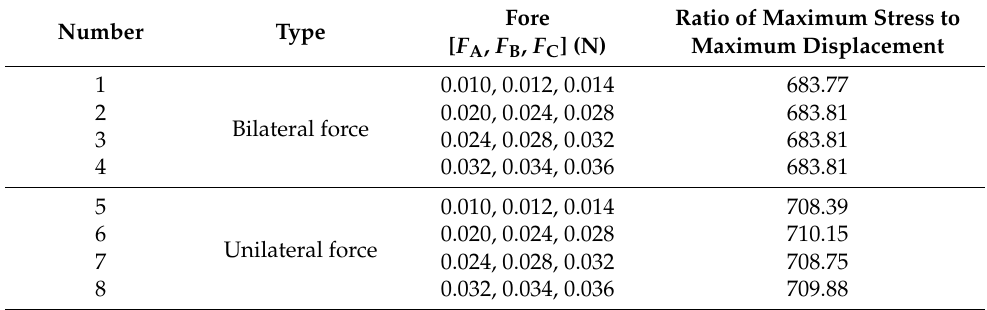
Table 1. Simulation results of driving system on working performance of the electromagnetic ISM.